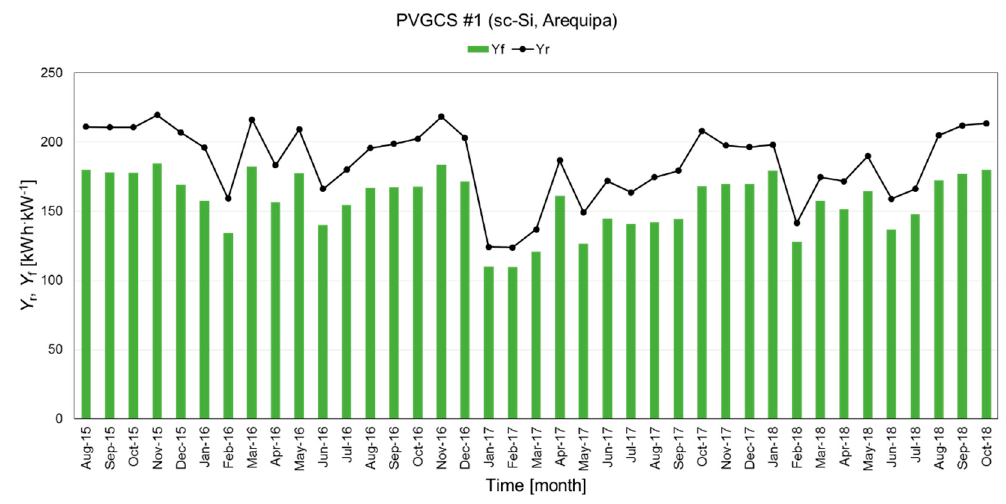
Figure 2. Values of Y r and Y f for PVGCS #1 over the period under scrutiny. Both the PV field and PVRD were left unclean.